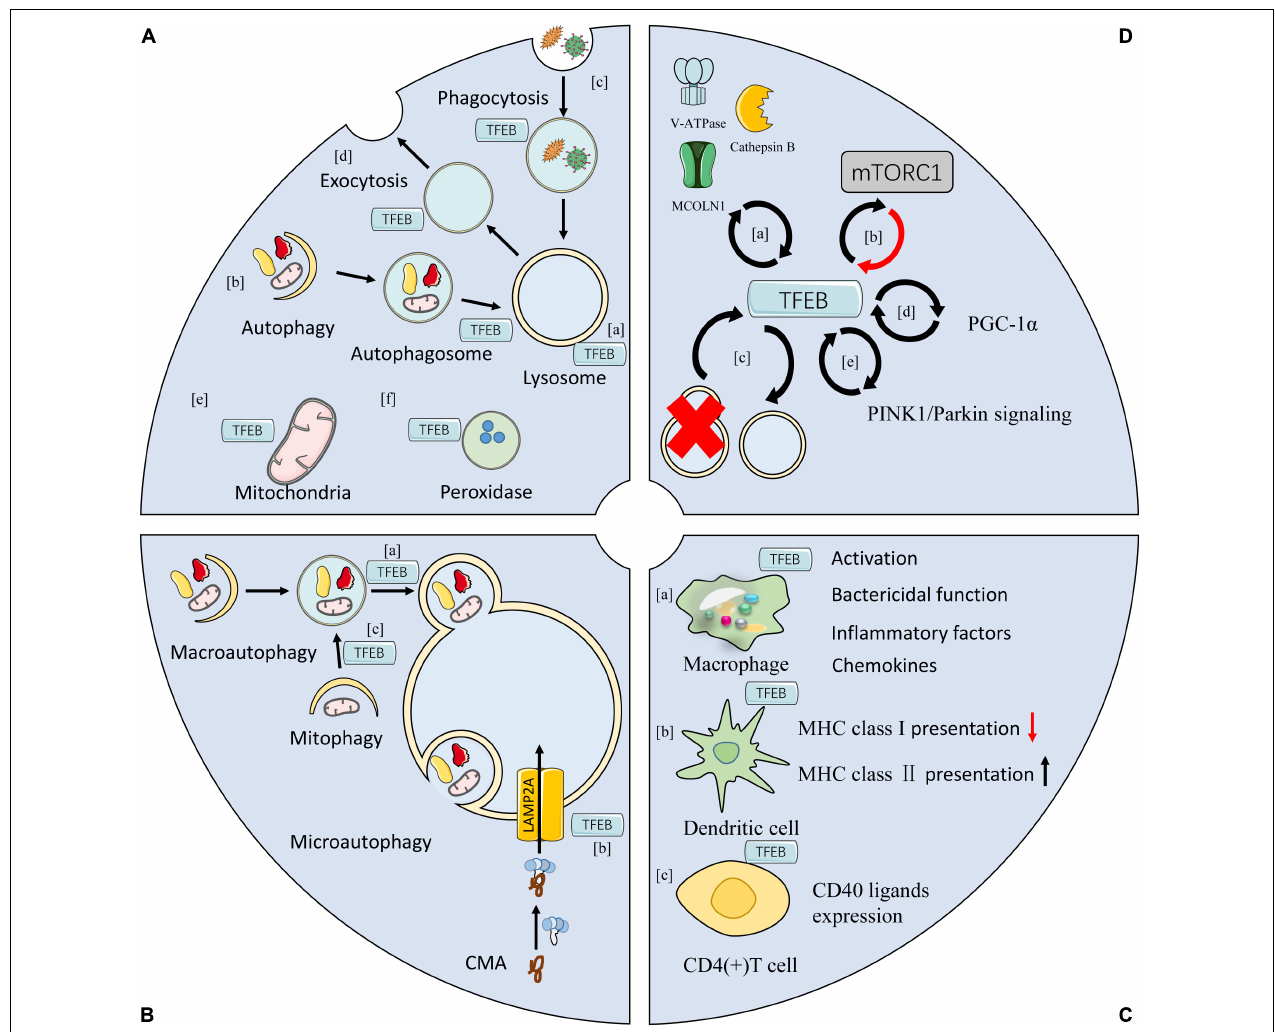
FIGURE 2 | Functions of TFEB. (A) TFEB is involved in the biogenesis of lysosomes (a), mitochondrial (e), peroxidases (f), and autophagosomes (b). (B) TFEB participates in multiple types of autophagy, including macroautophagy, microautophagy, and chaperone mediated autophagym (CMA) by regulating the function of lysosomes. It is also involved in autophagy at various steps, such as the fusion of autophagosome with lysosome in macroautophagy (a), the localization and trafficking of LAMP2A in CMA (b), and the priming the clearance of damaged mitochondrial in mitophagy (c). (C) TFEB regulates immune responses in both innate and adaptive immune systems. TFEB is involved in activation, bactericidal capacity, and production of inflammatory mediators in macrophages (a). In dendritic cells, TFEB inhibits the antigen presentation of MHC class I but enhances the expression of MHC class II (b). In T cells, TFEB is related to antibody response in reaction to the activation of CD40 at cellular surface (c). (D) The modulation of TFEB activity. Lysosomal proteins, such as V-ATPase, cathepsin B, and MCOLN1 that are induced by TFEB, can regulate TFEB activity in return (a). mTORC1 is critically involved in the TFEB phosphorylation, which can be activated by TFEB (b). TFEB is a major regulator of ALP, and both lysosomal damage and autophagy disruption result in TFEB activation (c). TFEB directly activate PGC-1 α , and it can be activated in a PGC-1 α -dependent manner (d). TFEB induces mitophagy by activating PINK1/Parkin pathway, and its activity is also enhanced by stimulating PINK1/Parkin (e). (mTORC1, mammalian target of rapamycin complex 1; CMA, chaperone mediated autophagy; PGC-1 α , peroxisome proliferator-activated receptor γ coactivator 1 α ; TFEB, transcription factor EB; MHC, major histocompatibility